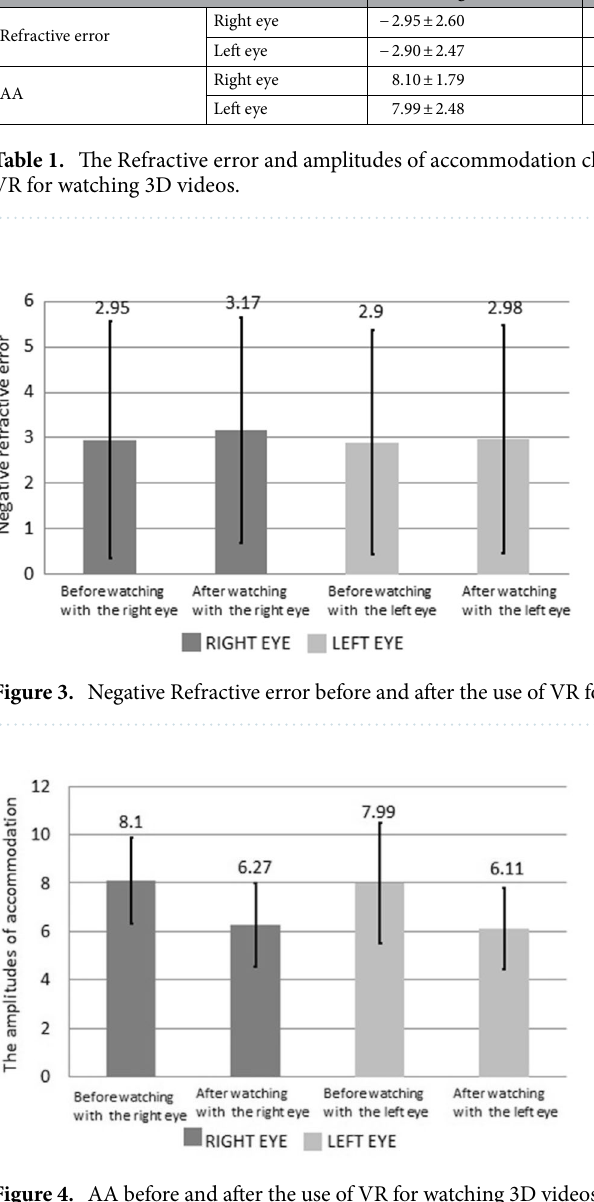
Figure 4. AA before and after the use of VR for watching 3D